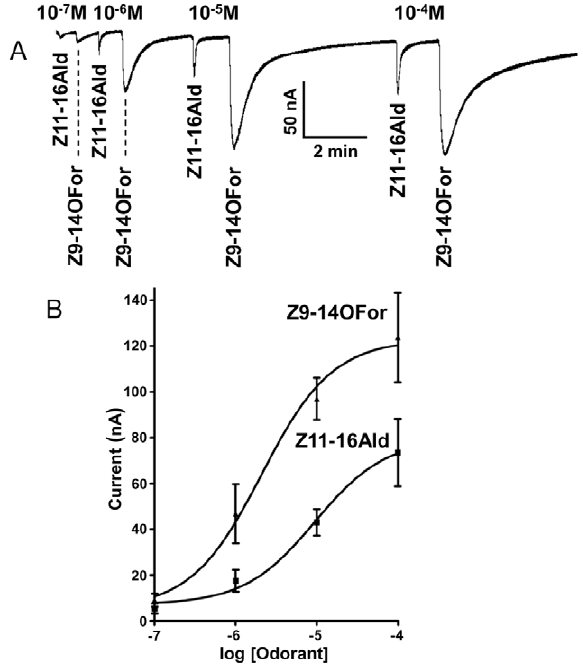
Figure 9. Current responses obtained from HvirOR13 N Hvir- Orco-expressing oocytes challenged with the cognate alde- hyde ligand and a related formate analog. (A) Trace generated with increasing doses of the two ligands, and (B) dose-dependent relationships, n =5.